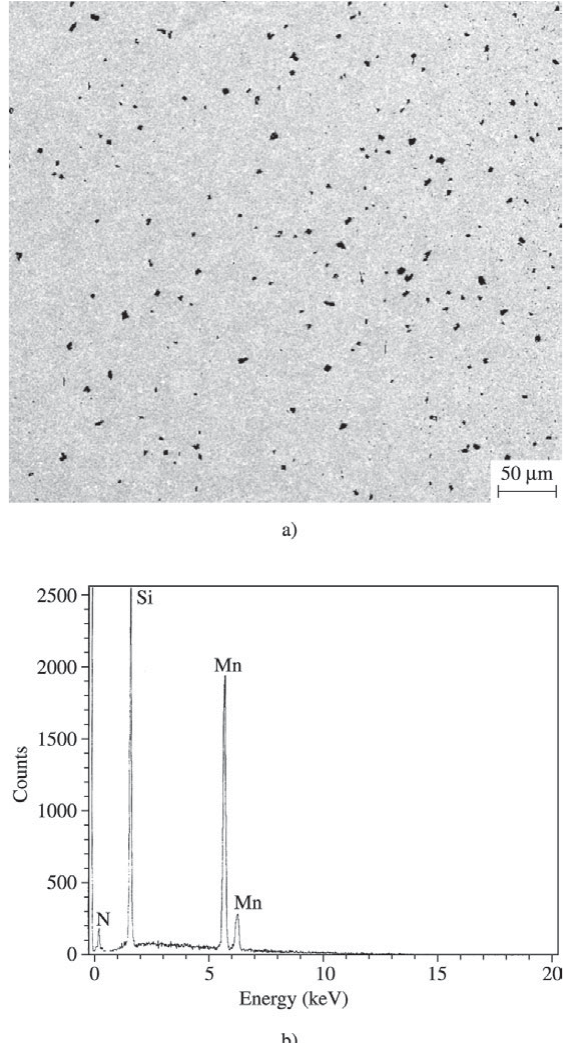
Figure 7. Detail of the internal precipitation of the G11 steel sam- ple at 700 °C in the real condition. a) SEM micrography illustrat- ing the morphology of the precipitates; b) EDS spectrum of the